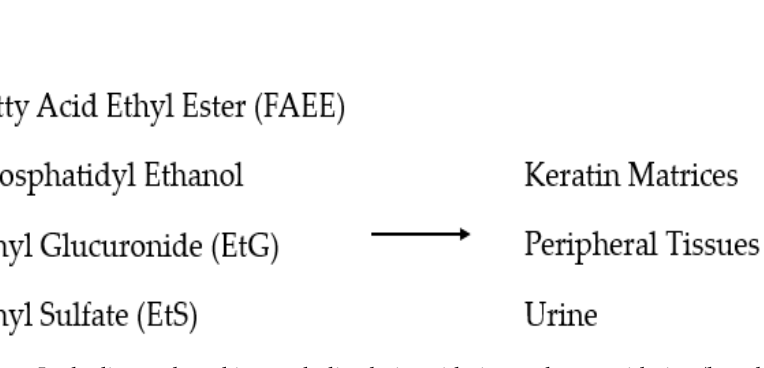
Figure 1. In the liver, ethanol is metabolized via oxidative and non-oxidative (less than 1%) ways. In the non-oxidative pathway, alcohol is finally processed as fatty acid ethyl ester (FAEE), phosphatidyl ethanol, ethyl glucuronide (EtG), and ethyl sulfate